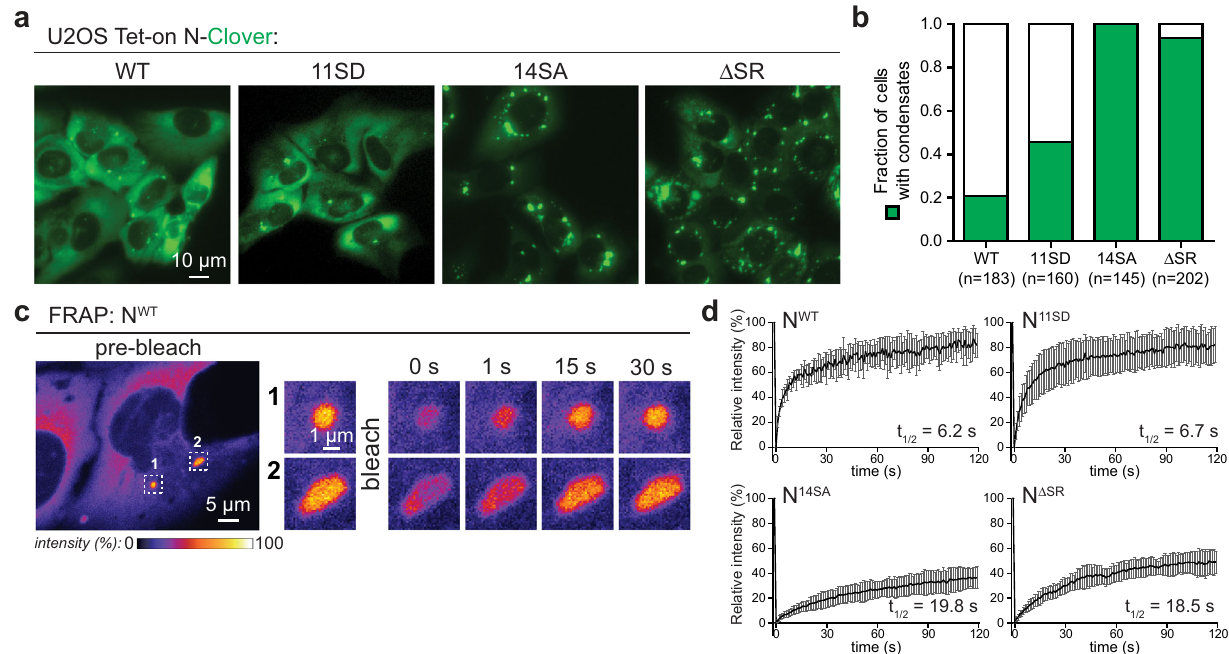
Fig. 5 The SARS-COV-2 N protein forms highly dynamic condensates in cells whose liquidity are likely regulated by phosphorylation. a Representative fl uorescence images of Clover-tagged N, N 11SD , N 14SA , and N Δ SR ( Δ 176 – 206) in U2OS cells. b Fraction of cells showing N protein condensates when expressing Clover-tagged N, N 11SD , N 14SA , or N Δ SR . See Supplementary Fig. 6 for analysis with SRPK and GSK3 kinase inhibitors. N represents number of cells counted in each experiment. c Representative example of FRAP analysis of Clover-tagged wild-type N protein. Enlarged pictures are fl uorescence images of one condensate after partial photobleaching (1) and one after full photobleaching (2). Scale bar, 5 µ m for original image and 1 µ m for enlarged images. d Mean fl uorescence intensity plot for FRAP analysis of Clover-labeled N ( n = 7 droplets), N 11SD ( n = 9 droplets), N 14SA ( n = 13 droplets), and N Δ SR ( n = 10 droplets) in cells. See Supplementary Fig. 5 for full images of N WT , N 11SD , N 14SA , and N Δ SR . Mean average data are normalized to the average intensity of a particle before photobleaching and are represented as mean ± standard deviation from the recovery